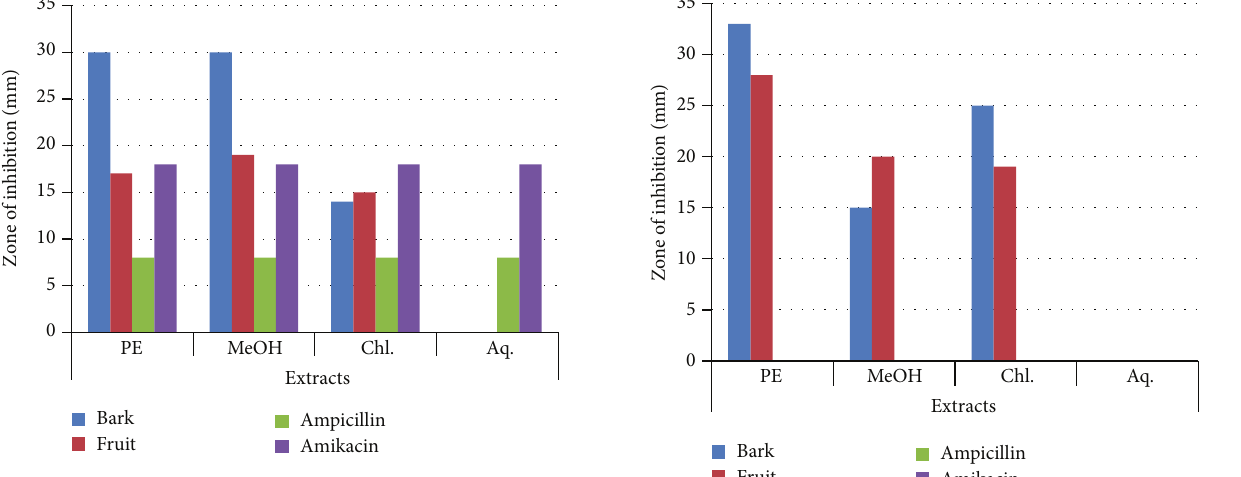
Figure 4: Zone of inhibition produced by different parts of C. ambrosioides against S. aureus.